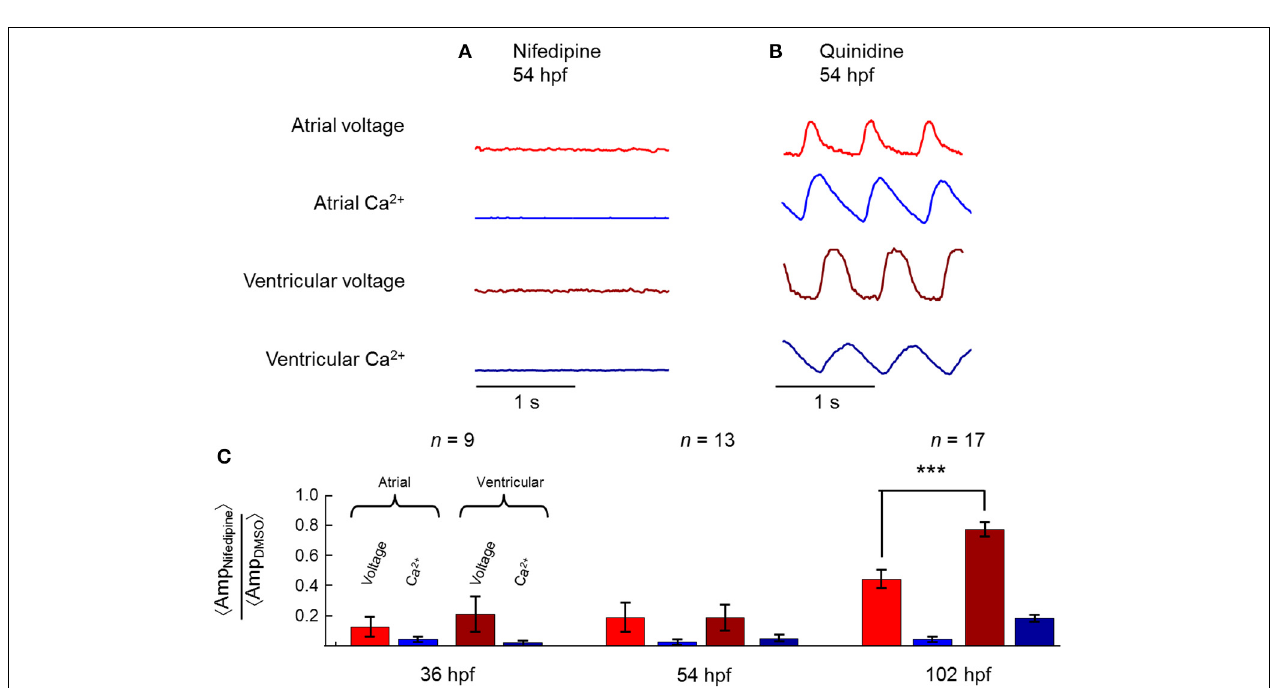
sodium current, largely suppressed voltage and calcium transients in the ventricle, but did not affect either transient in the atrium. (C) Quinidine sometimes showed partial suppression of ventricular activity, leading to an atrial-ventricular block.